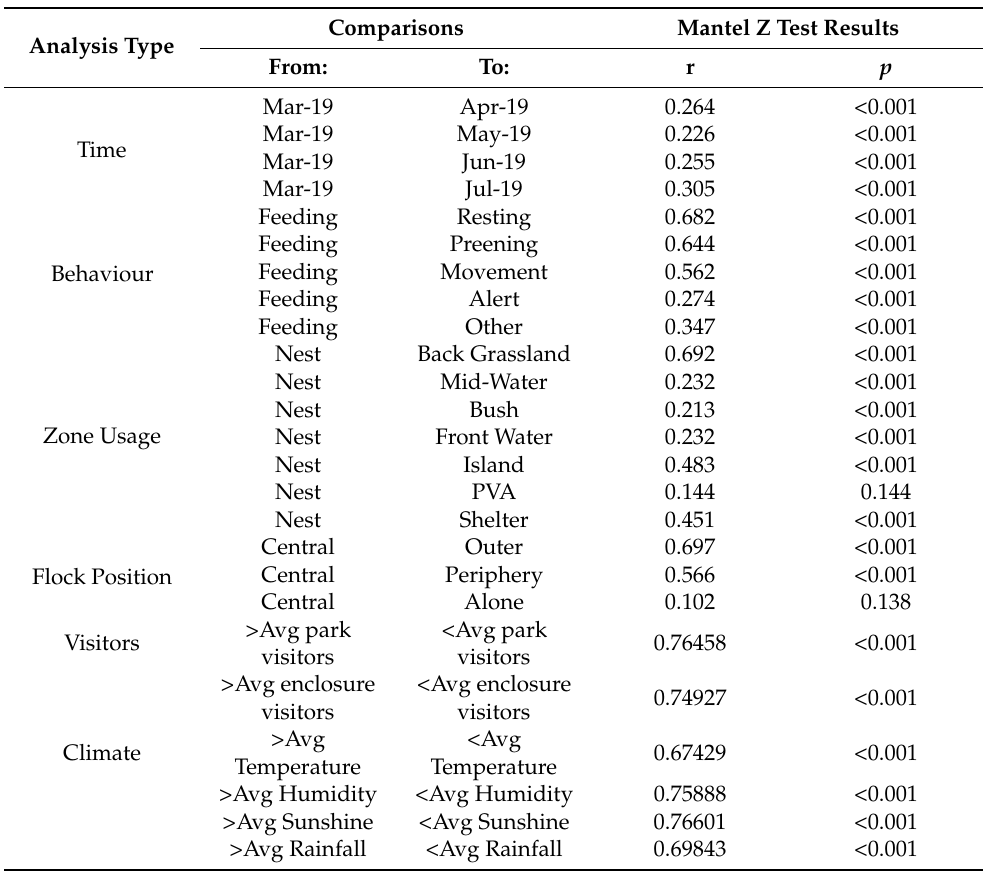
Figure 7. Lagged and null association rates of a typical ( a ) foster-reared and ( b ) parent-reared Chilean flamingo chick dyad. Lagged association and null association rates are plotted using a moving average of 10,000 recorded associations. Best fitting models indicated two levels of casual acquaintances for foster-reared chicks, and rapid dispersal and casual acquaintances for parent-reared chicks. Differences between the null and lagged association rate indicate that chicks held stronger bonds than expected from random association. Table 5. Mantel Z test results comparing the fit of association matrices across time, behaviours, zones, and flock positions, visitor numbers, and